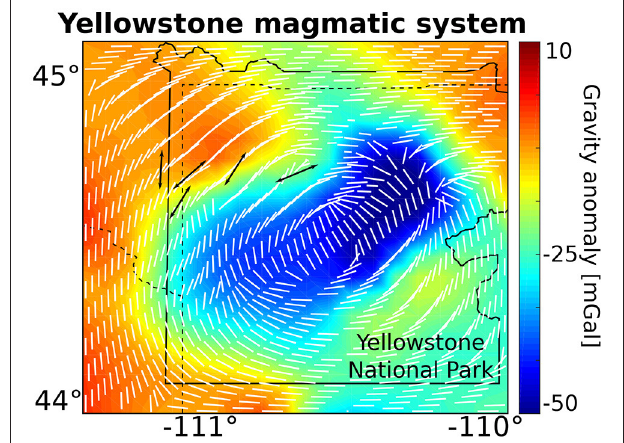
FIGURE 6 | Orientation of the minimum principal stress. Black arrows represent the orientation of the minimum principal stress taken from Waite and Smith (2004) and references therein. White arrows show the result of the simulation with no connection between the reservoirs, while grey arrows show the result of the simulation with connected reservoirs and a mantle plume ( Figure 5C ). The stress orientation is computed at the surface. Results reproduce the rotation of the stress field from West-East to North-South. Furthermore, the connected vs. the unconnected case do not show significant